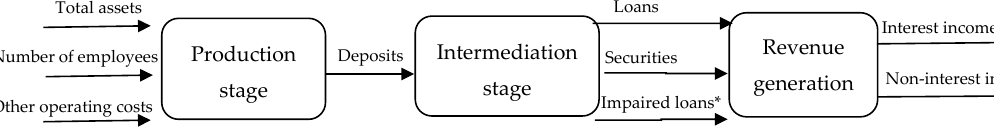
Figure 1. Structure of the three-stage model. NB : * Since it is an undesired output, an inverse transformation of the impaired loans is applied as the output of the second stage.